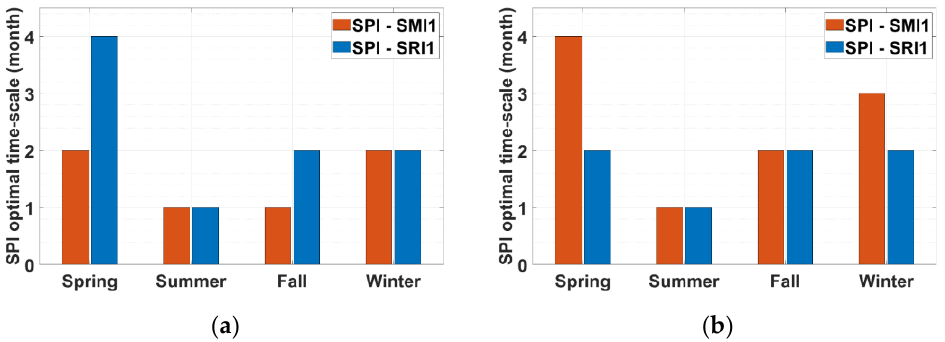
Figure 5. Optimal timescale between SPI-m and SMI-1 (or SRI-1): ( a ) Andong Dam Basin; ( b ) Hapcheon Dam Basin.